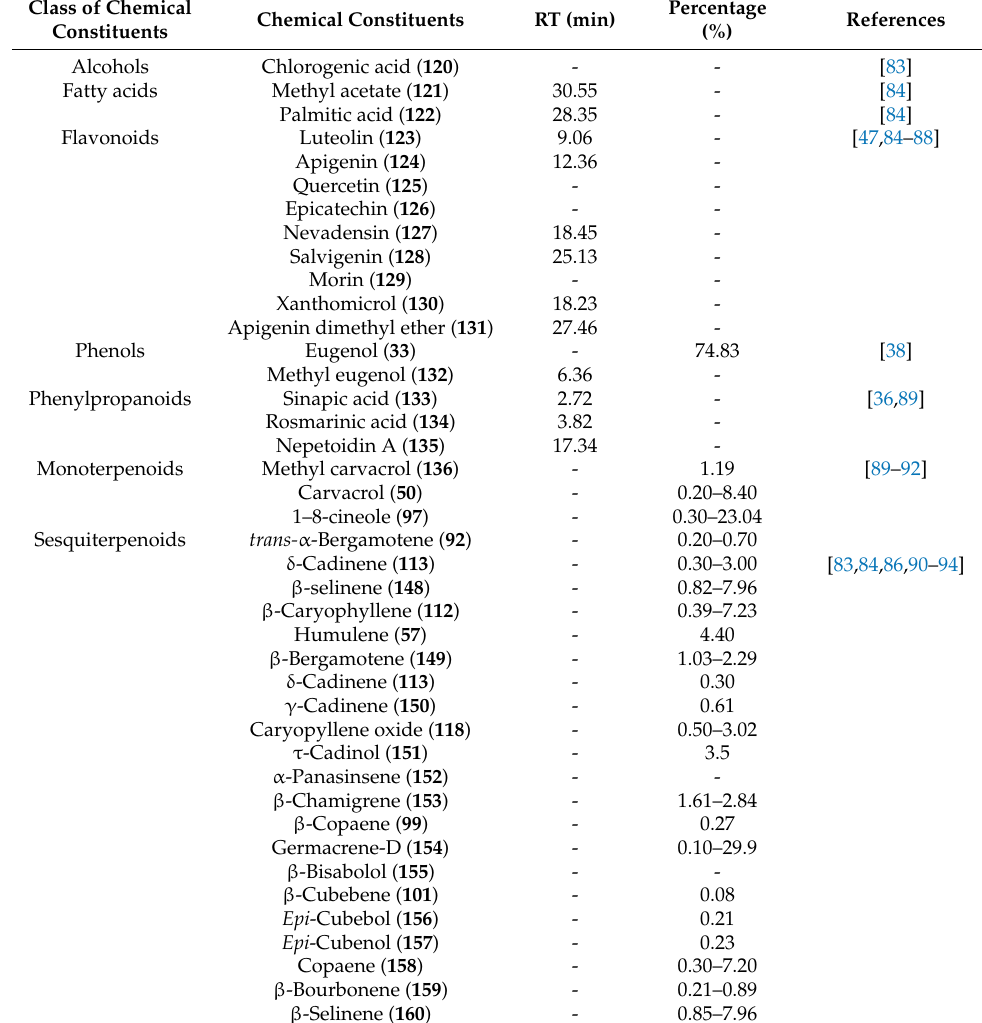
Table 3. The chemical constituents of O. gratissimum